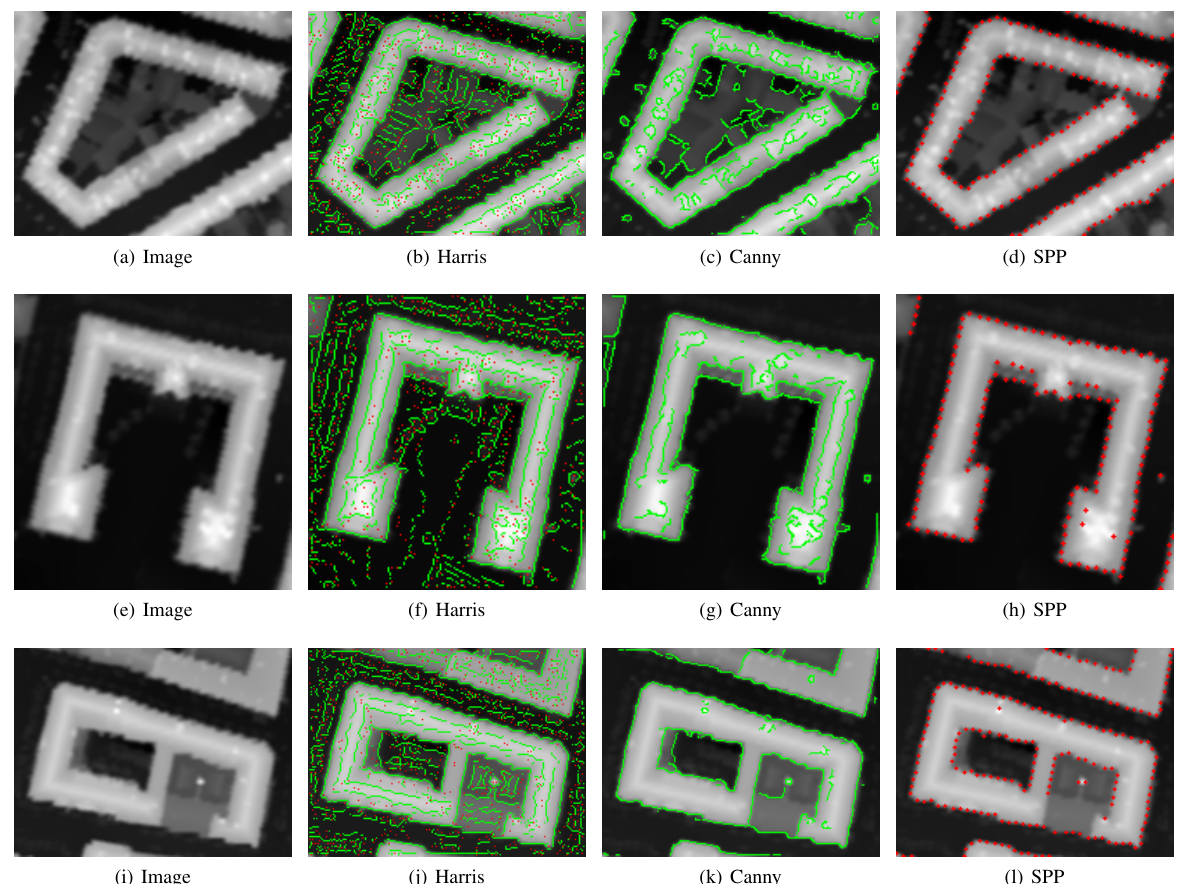
Figure 6: Experimental results: The images and features detected by the Harris, the Canny and the new spatial point process based detector are indicated by the captions. The corners and edges are depicted as red and green pixels, respectively. The points on the linear features are also depicted as red